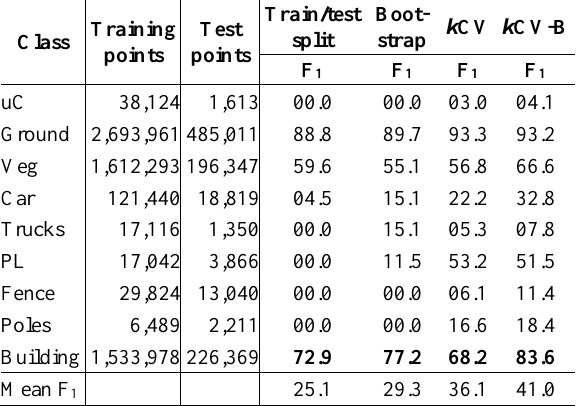
Table 2. Classification results of DALES Test 3 data